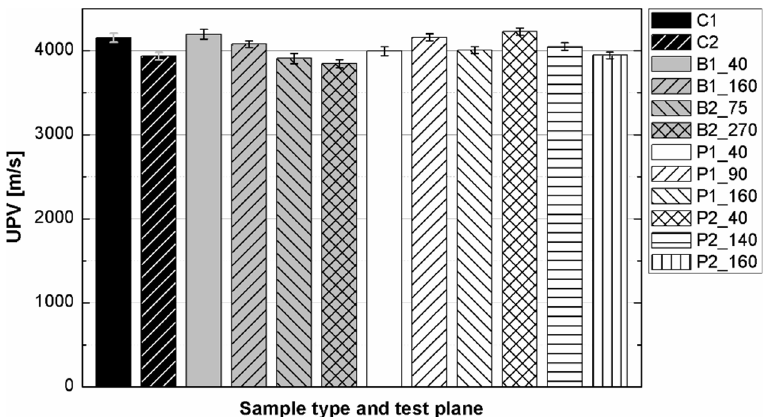
Figure 6. Pulse velocity in epoxy concrete depending on the sample type and test plane.